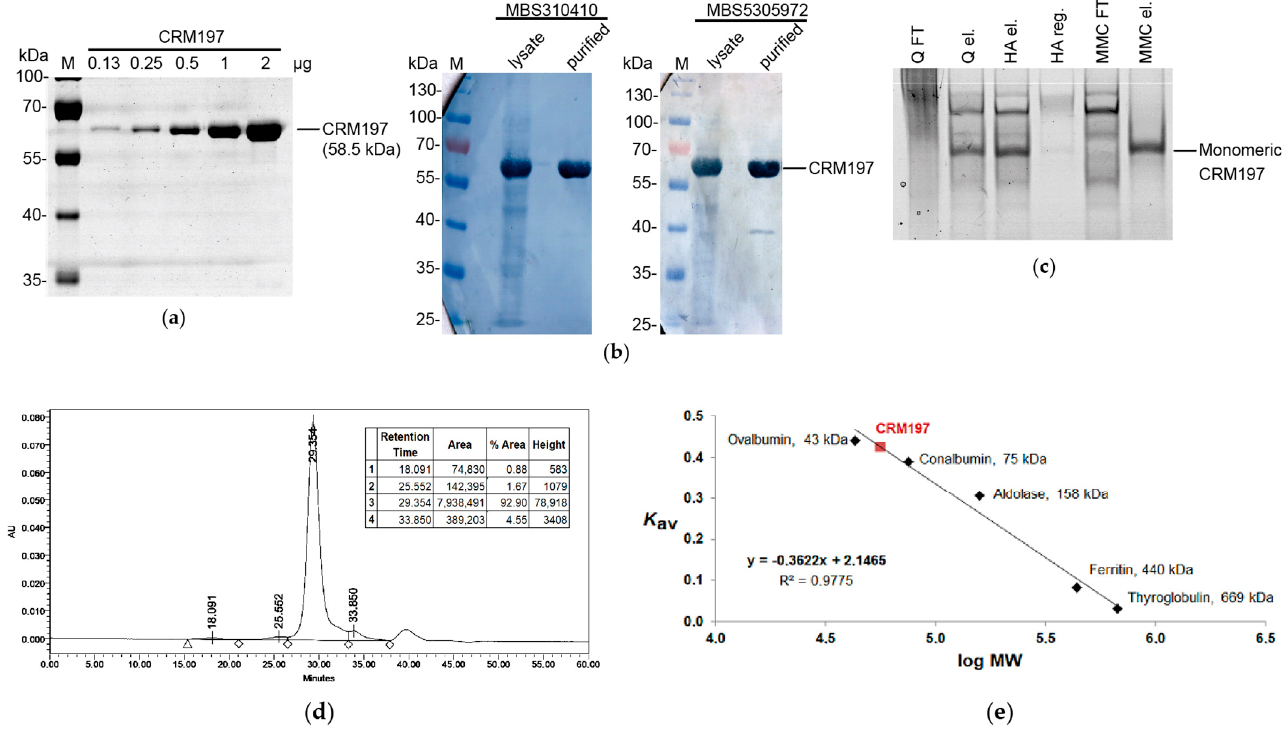
Figure 4. Analysis of the purified soluble CRM197. ( a ) Increasing concentrations of the purified CRM197 analyzed by Laemmli gel electrophoresis under reducing conditions. ( b ) Detection of CRM197 using Western blotting with monoclonal anti-DT antibodies MBS310410 and MBS5305972 (MyBioSource). Lanes 1 and 3, cell lysate; lanes 2 and 4, the purified CRM197. ( c ) Analysis of samples taken at different CRM197 purification stages using native gel electrophoresis. The samples are